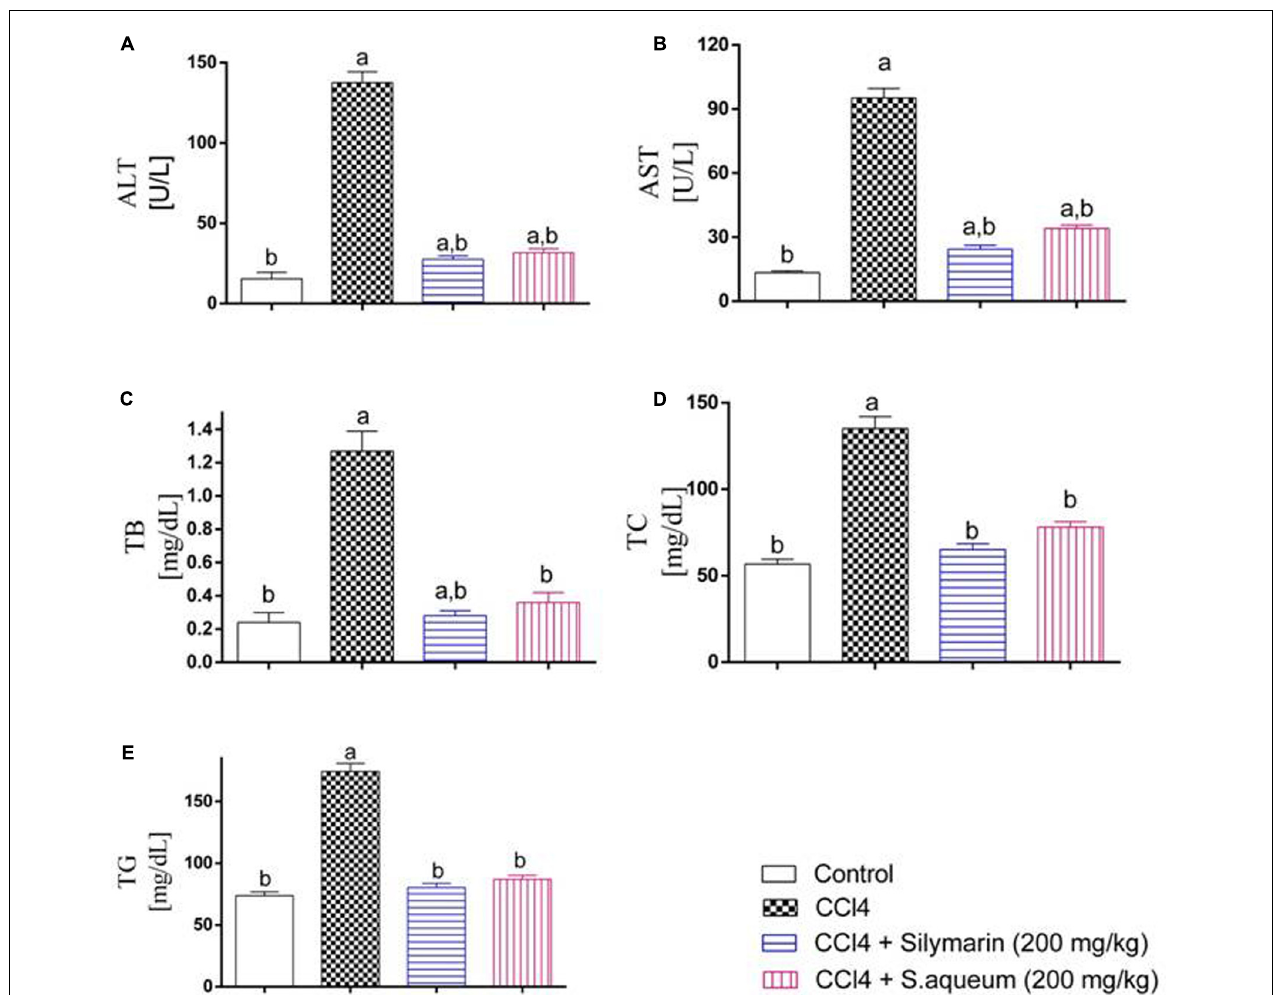
FIGURE 3 | Hepatoprotection through a methanol extract of S. aqueum leaves in a rat model of acute CCl 4 intoxication. (A) Alanine aminotransferase (ALT) activity; (B) Aspartate aminotransferase (AST); (C) Total bilirubin (TB); (D) Total cholesterol (TC); (E) Triglycerides (TG). Results are shown as means ± SD, n = 6, by one-way ANOVA followed by Tukey post hoc test. a Statistically significant from the corresponding control at p < 0.05, b Statistically significant from CCl 4 -treated group at p <